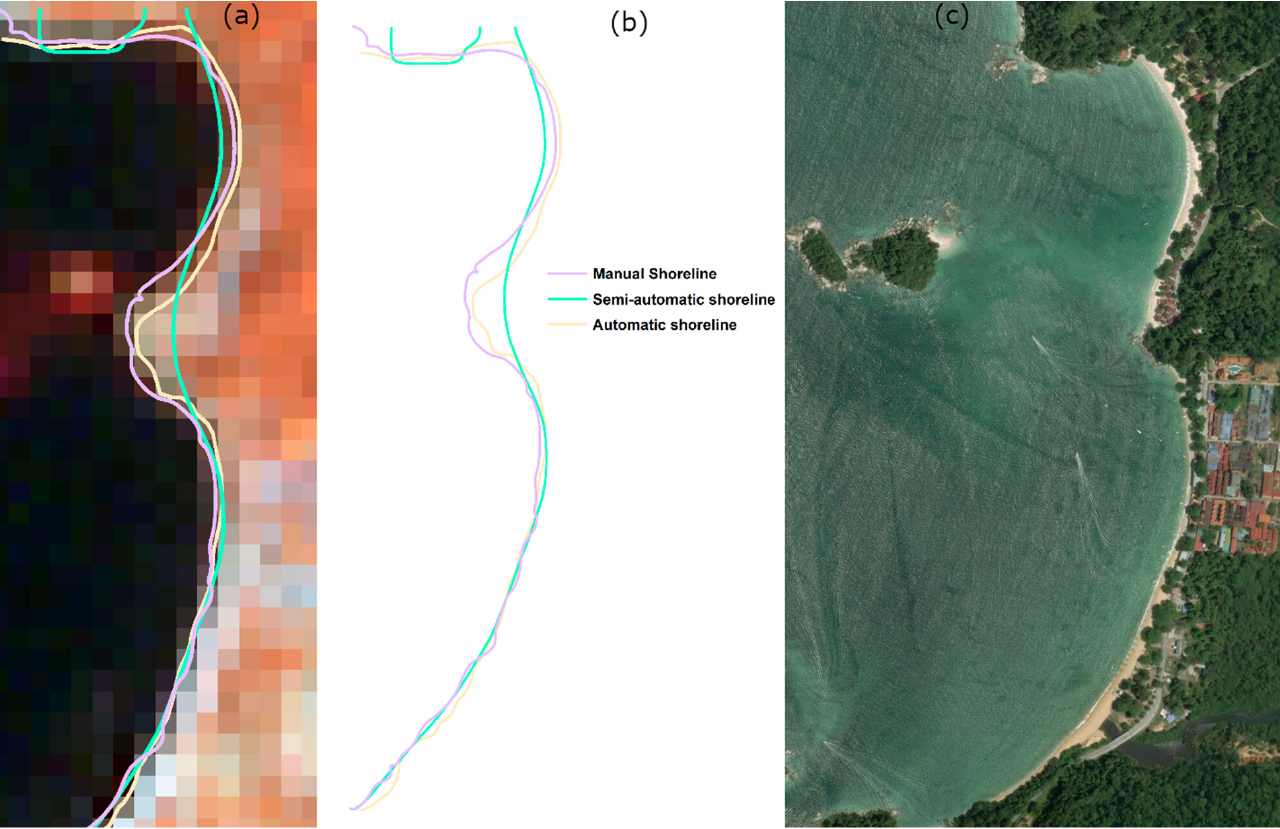
Figure 8. ( a ) Band 4, 5, 7 composite of Landsat 7 and extracted shorelines. ( b ) Manual, semi-automatic, and automatic shorelines extracted from the image. ( c ) Base map imagery of the study area (base map by Google Satellite).